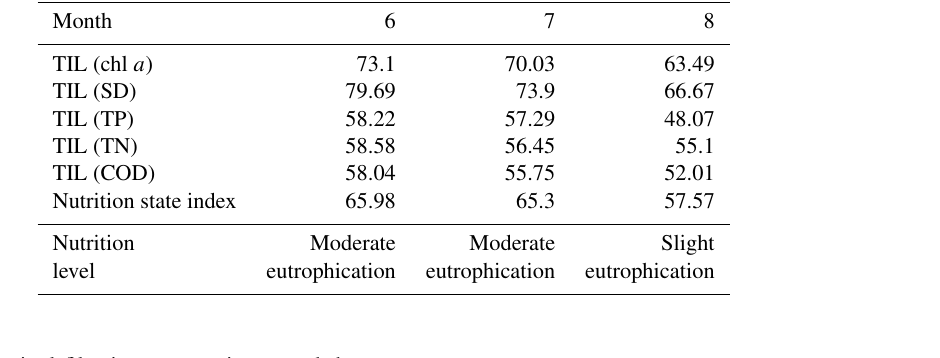
Table 1. Evaluation results of the outflow water eutrophication in the ecological filtering system.